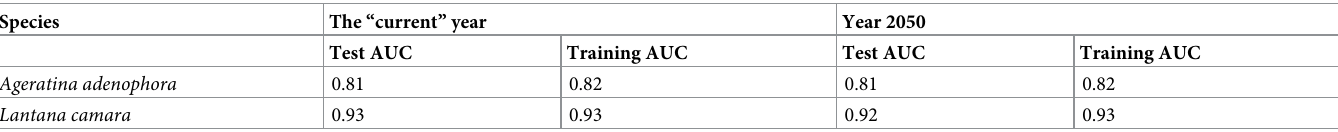
Table 2. The area under the receiver operating curve (AUC) score of MaxEnt models for both Ageratina adenophora and Lantana camara .